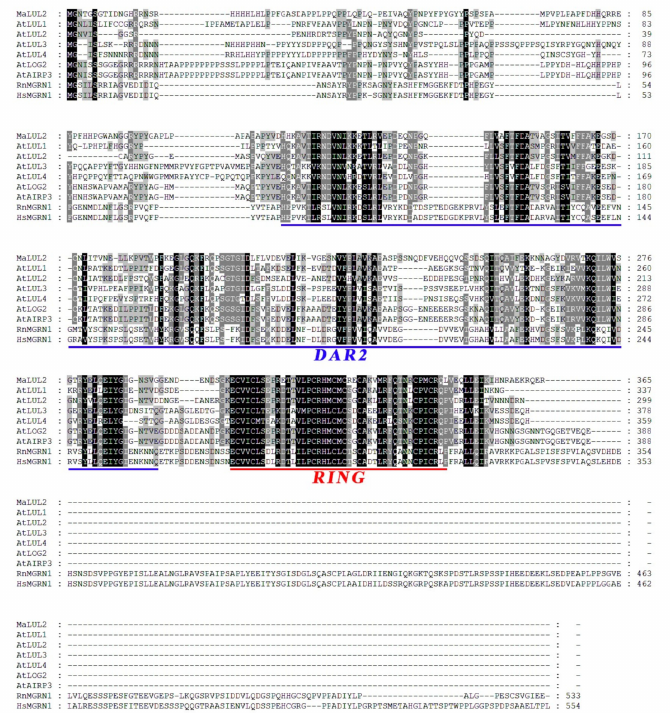
Figure 2. Multiple sequence alignment of MaLUL2. Identical and similar amino acids were shaded in black and grey, respectively. The DAR2 domain and RING motif are underlined with blue and red, respectively. The following proteins were used for analysis: AtLUL1 (NP_195940.1), AtLUL2 (NP_190909.1), AtLUL3 (NP_197409.1), AtLUL4 (NP_566274.1), AtLOG2 (NP_566356.1), AtAIRP3 (NP_566356.1), RnMGRN1 (NP_001013986.1), and HsMGRN1